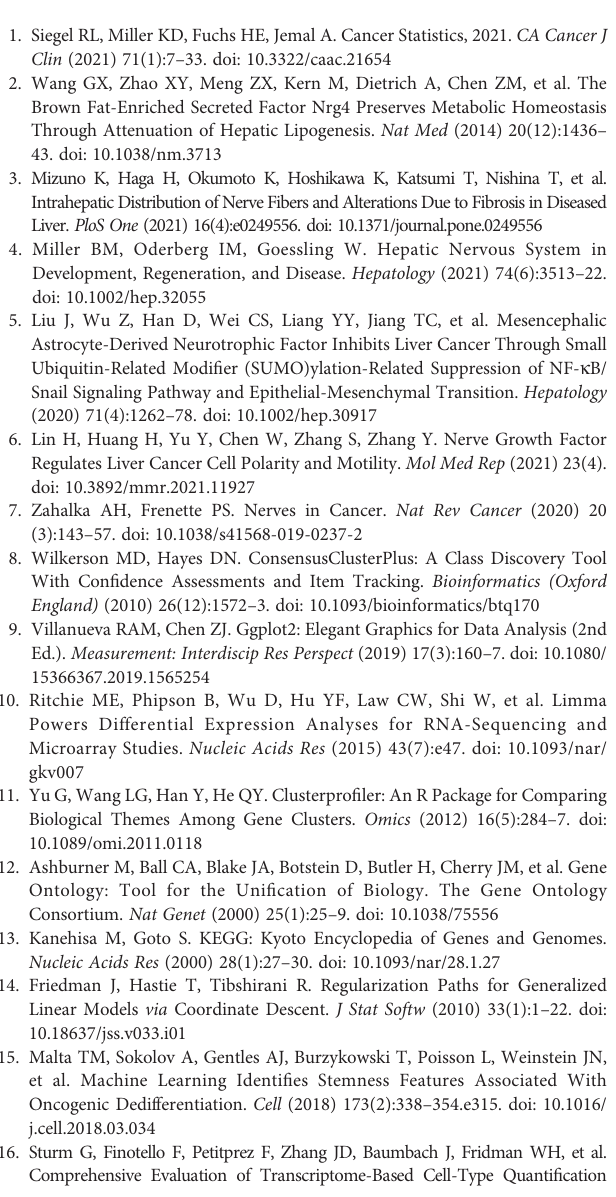
Supplementary Figure 1 | Comparisons of 38 neural-related gene expression between C1 and C2. Supplementary Figure 2 | The construction of a prognostic model based on 4 differentially expressed neural-related genes. Supplementary Figure 3 | Comparisons of clinical characteristics between high and low CHRNE/GFRA2/GFRA3/GRIN2D groups. Comparisons of T category, N category, Mcategory, TNMstaging,andpathologicalgradingbetween (A) CHRNE - high and -low group; (B) GFRA2 -high and -low group; (C) GFRA3 -high and -low group; (D) GRIN2D -high and -low group. Supplementary Figure 4 | Differential expression and enrichment analysis of high and low GFRA2 expression groups.